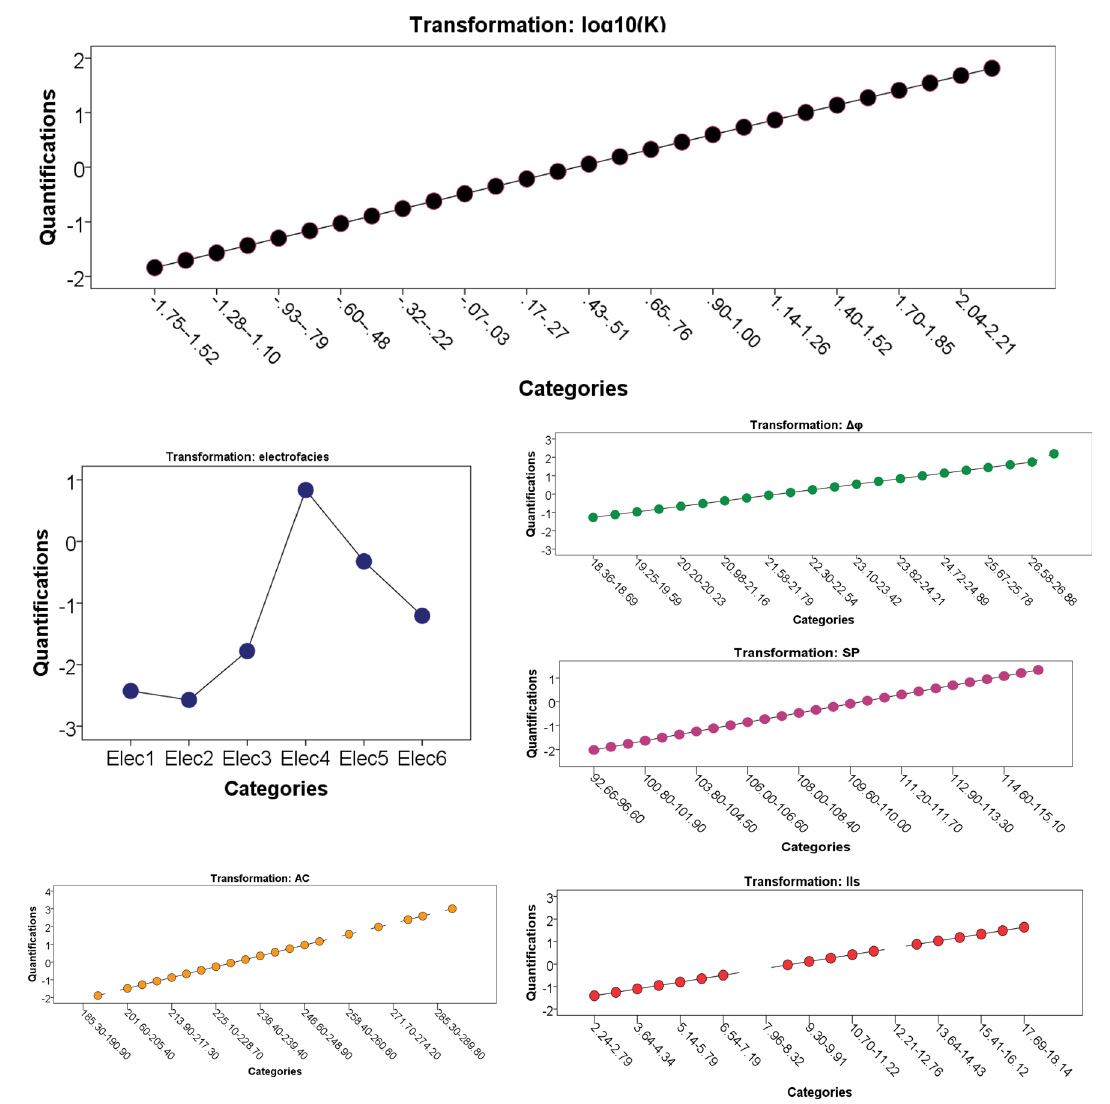
Fig. 19 Variables transformation by optimal scale analysis